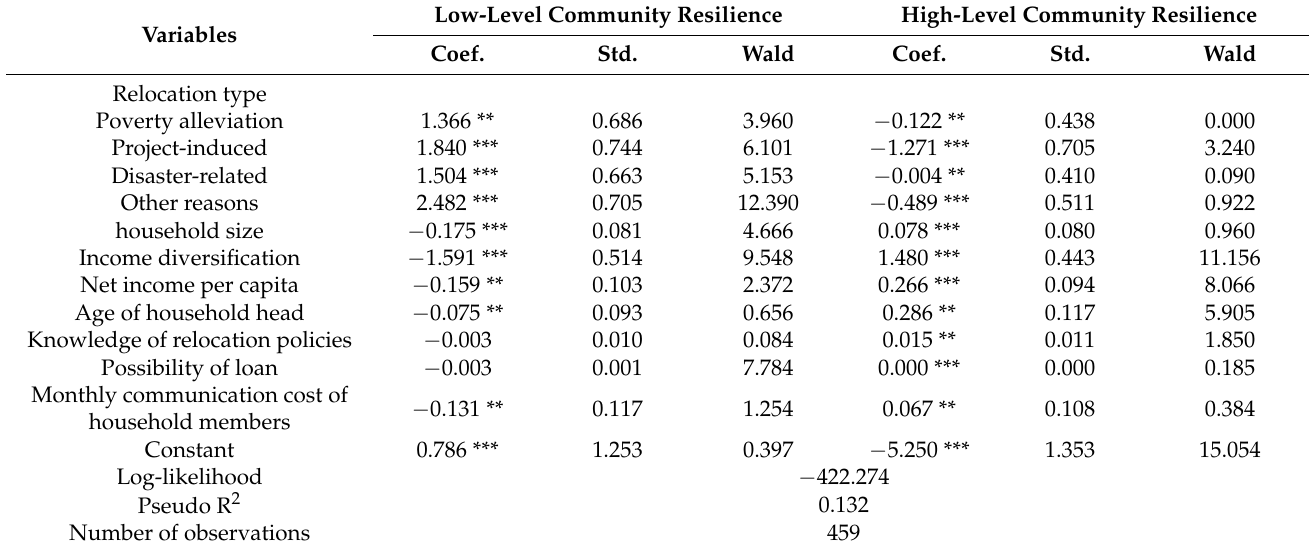
Table 5. The effect of relocation type on the community resilience of relocated households in the case of PAR.